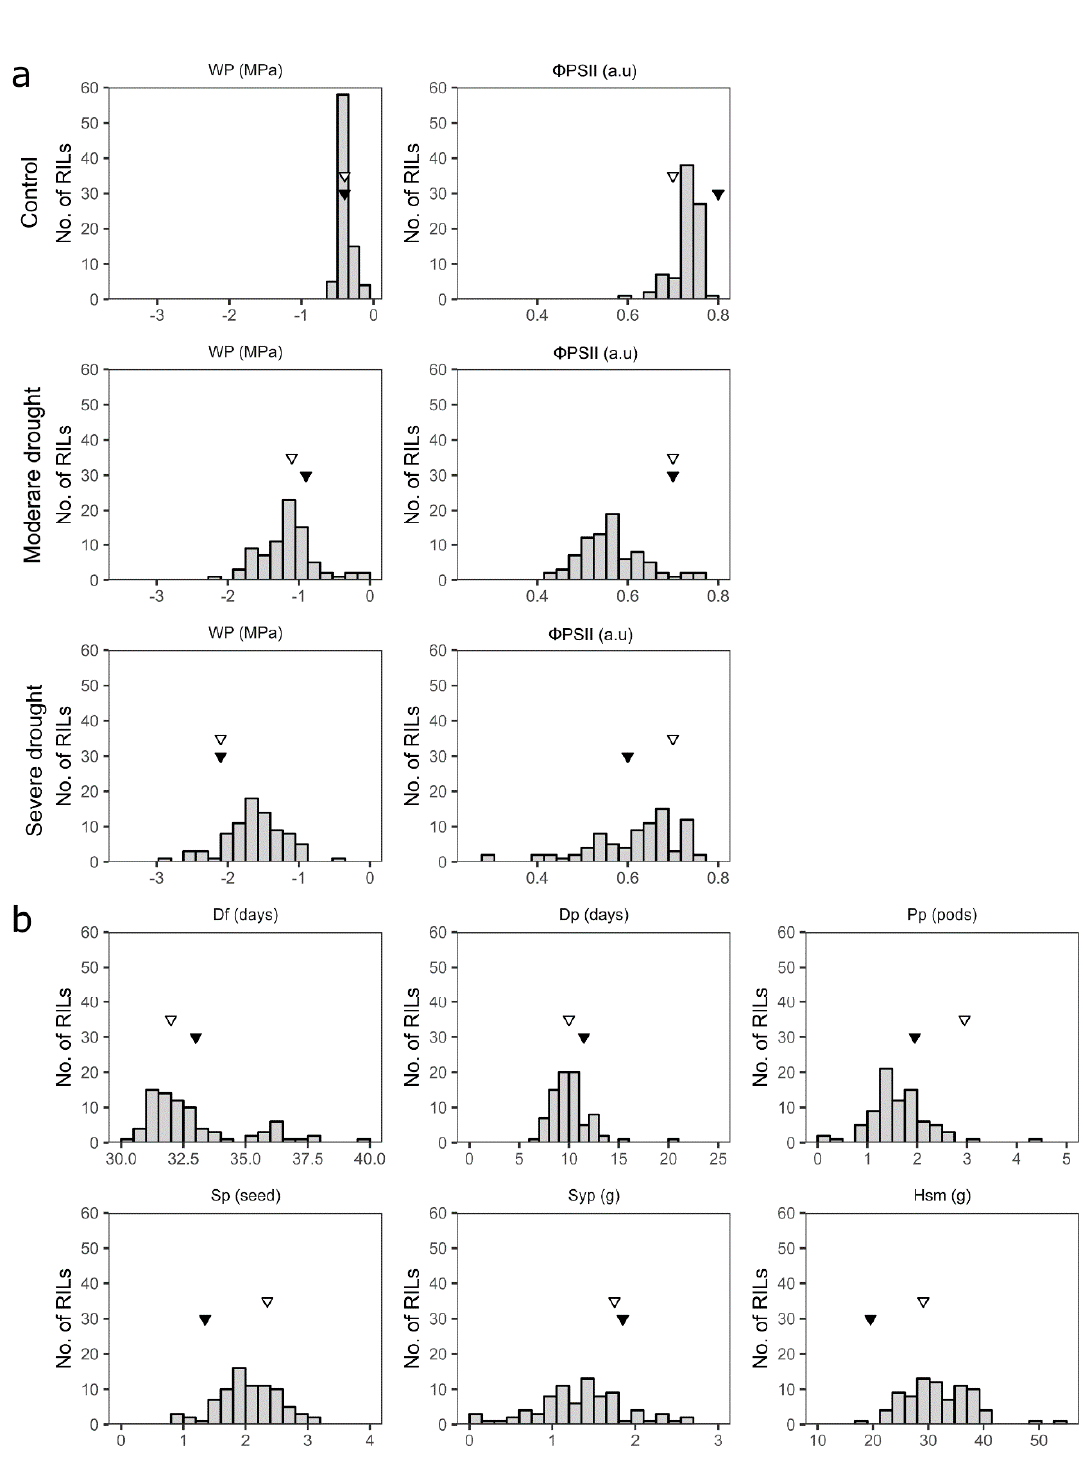
Figure 3. Trait distribution in a recombinant inbred line (RIL) population of ‘Tiber’ × ‘Starozagorski’ cross evaluated in greenhouses in Ljubljana in seasons 2013 and 2014. ( a ) Distribution of leaf water potential (Wp) and the effective quantum yield of photosystem II (PSII, Φ PSII) in watered plants and plants exposed to moderate and severe drought. ( b ) Distribution of days to flowering (Df), days to pod-setting (Dp), pods per plant (Pp), seeds per pod (Sp), seed yield per plant (Syp), and 100 seed mass (Hsm) in plants that underwent a period of drought. Values for parental genotypes are indicated by triangle symbols (white—‘Tiber’, black—‘Starozagorski’).